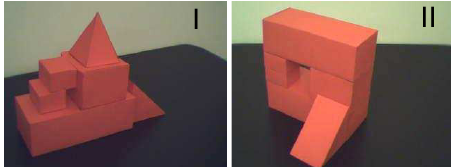
Figure 8. Illustrative photo of investigated structures.